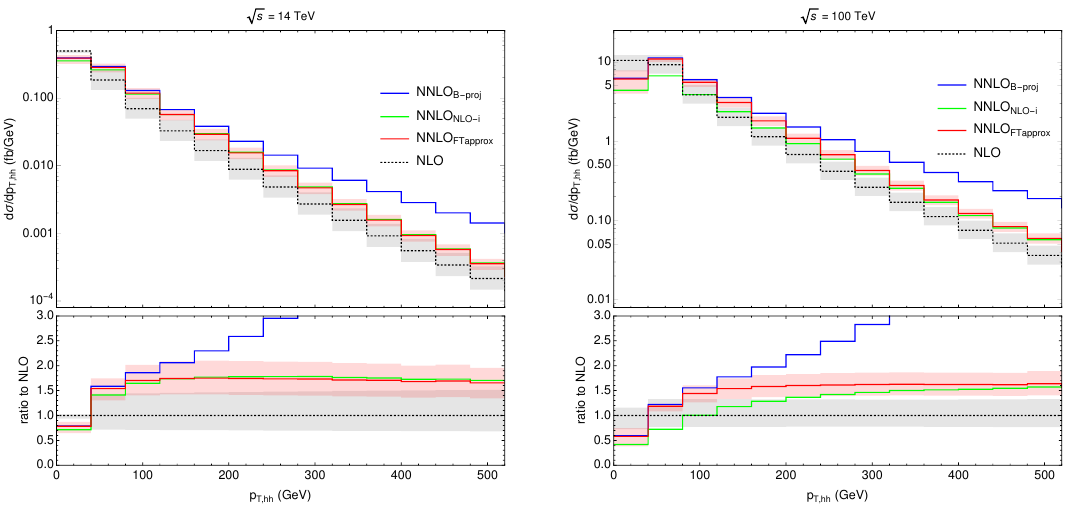
Figure 4 . Higgs boson pair transverse momentum distribution at 14 TeV (left) and 100 TeV (right).